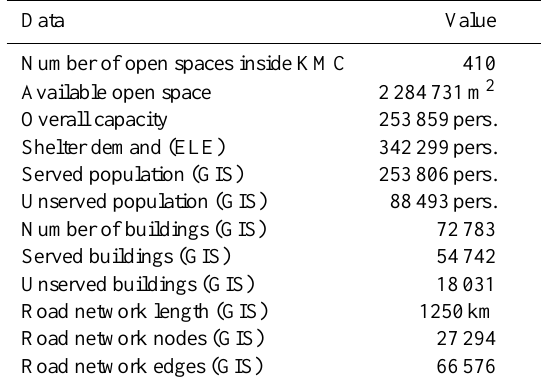
Table 3. Key characteristics of the used database.